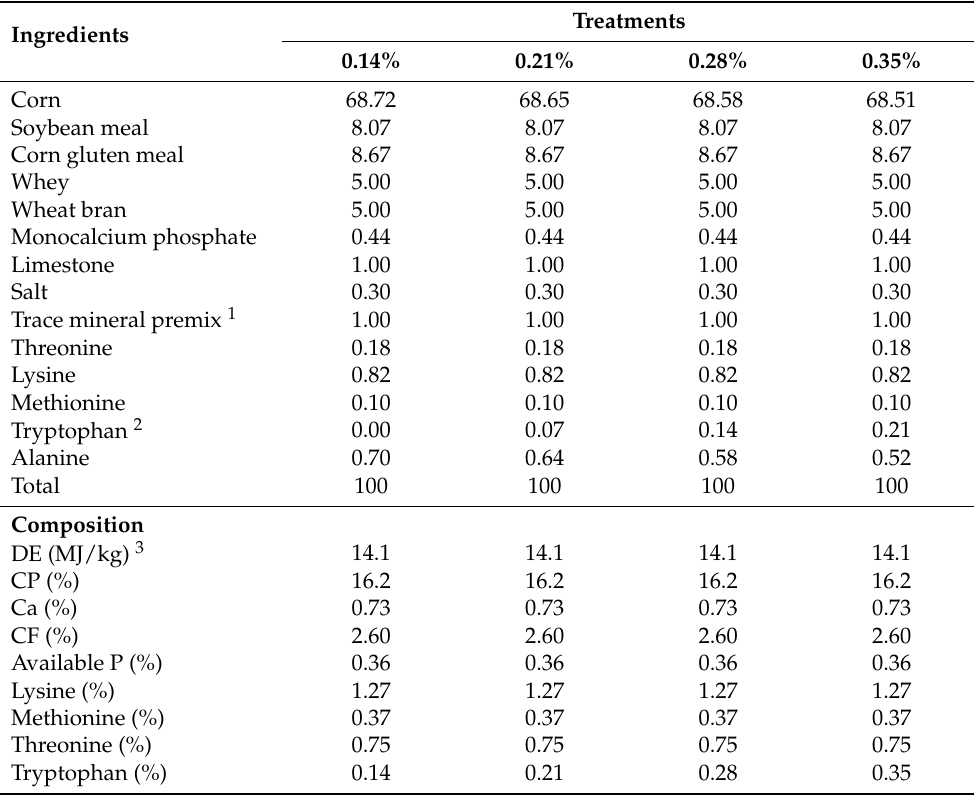
Table 1. Ingredients and composition of experiment diets (DM basis).